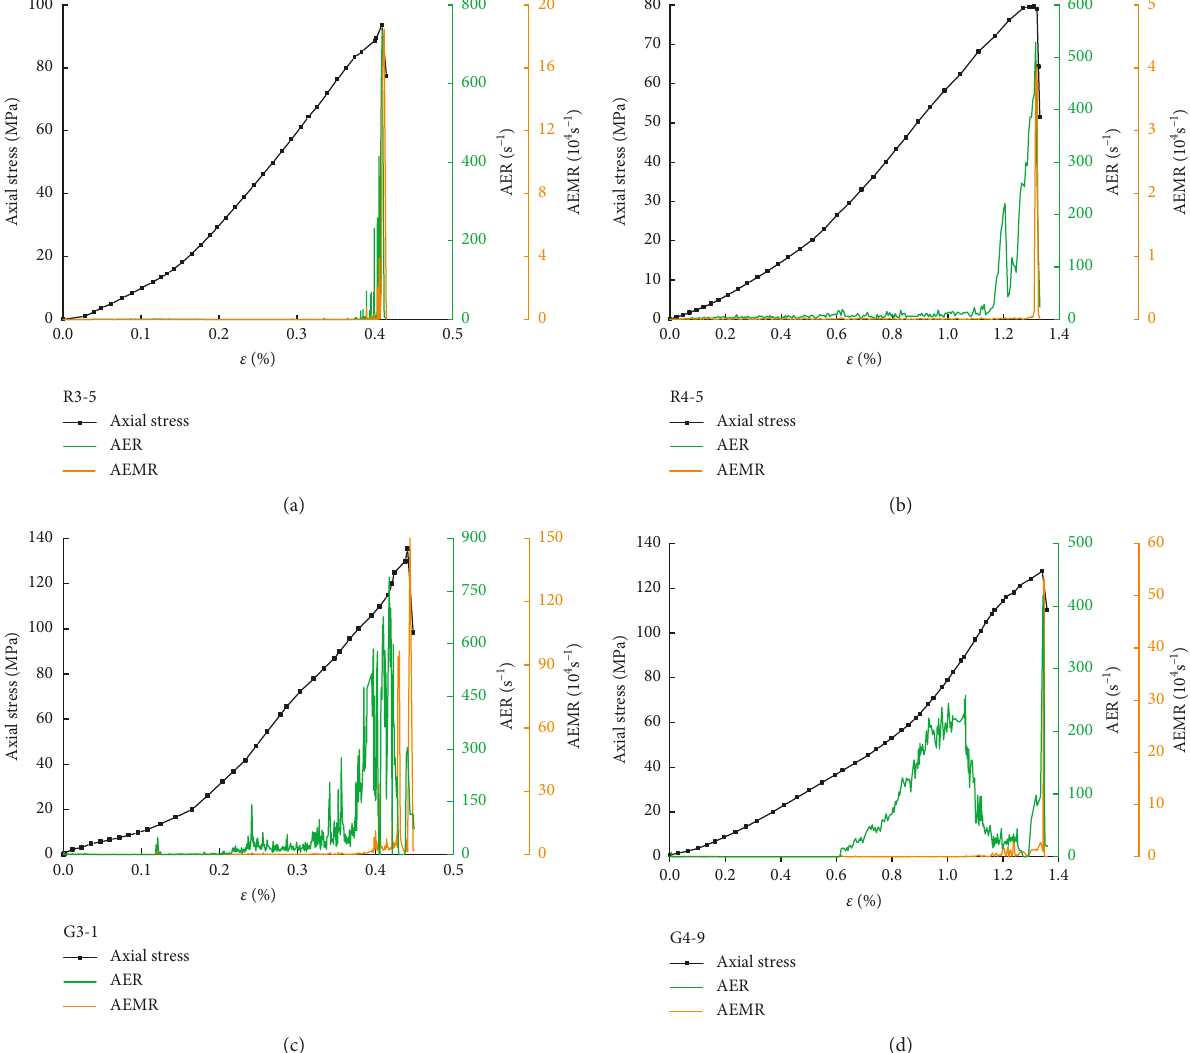
Figure 5: Time series characteristics of AEMR and AER for different samples. (a) Cubic red sandstone. (b) Cylindrical red sandstone. (c) Cubic granite. (d) Cylindrical granite.